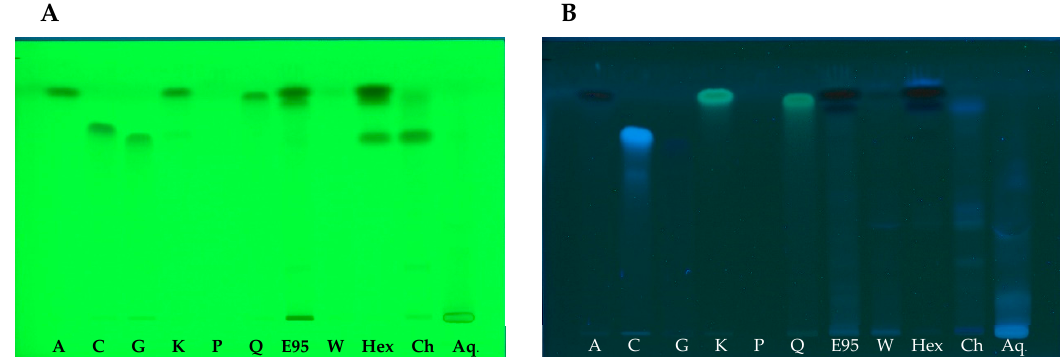
Figure 3. The high-performance thin-layer chromatography (HPTLC) chromatogram ( A ) at 254 nm; ( B ) at 366 nm. A = apigenin; C = caffeic acid; G = gallic acid; K = kaemferol; P = pinene; Q = quercetin; E = ethanolic crude extract; W = water crude extract; Hex = n-hexane fraction; Ch = chloroform fraction; and Aq = aqueous alcohol fraction.